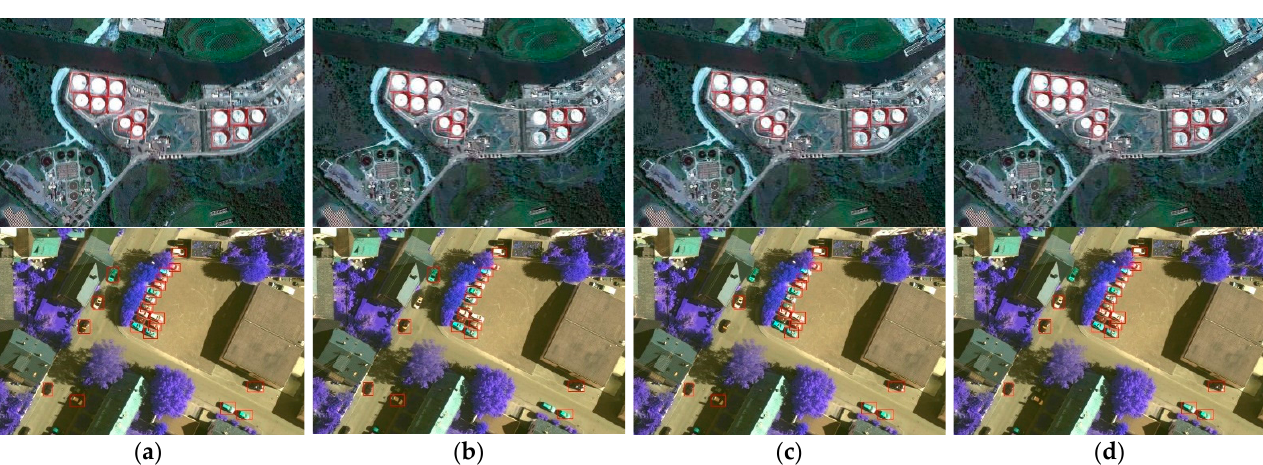
Figure 10. The P-R curves of different frameworks with the NWPU VHR-10 dataset. ( a ) Faster-